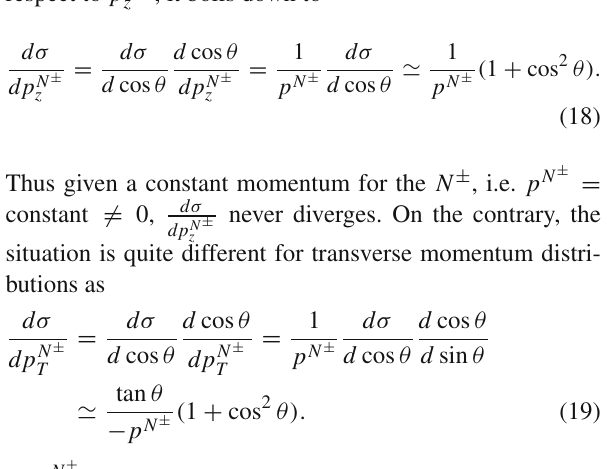
of two leptons for pre and post jet-lepton isolation, respectively for B ( N ± → he ± ) = 100%. c Describes the scenario for the isolated leptons obeying the branching ratio of